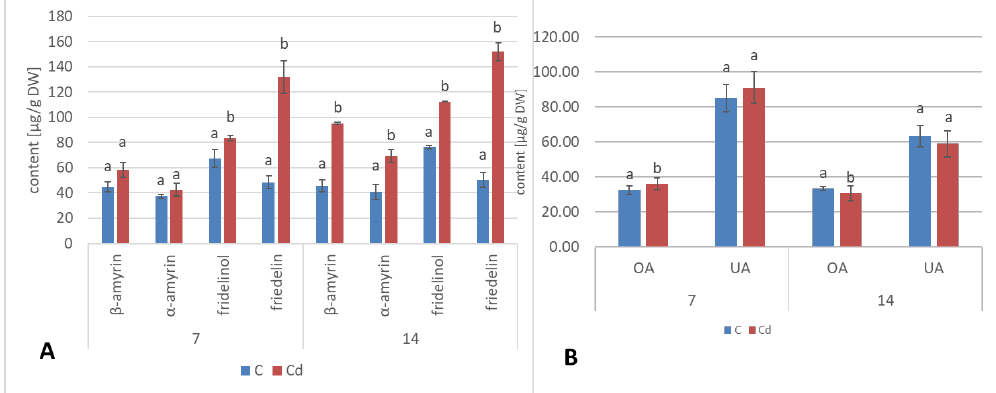
Figure 22. The content of neutral triterpenoids ( A ) triterpenoid acids ( B ) and in C. officinalis roots. OA — oleanolic acid, UA — ursolic acid. Bars which do not share a common letter are significantly different ( p < 0.05).